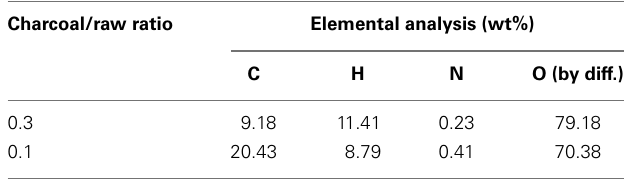
Table 3 | Elemental analyses of bio-oil from bagasse pyrolysis under microwave-assisted heating